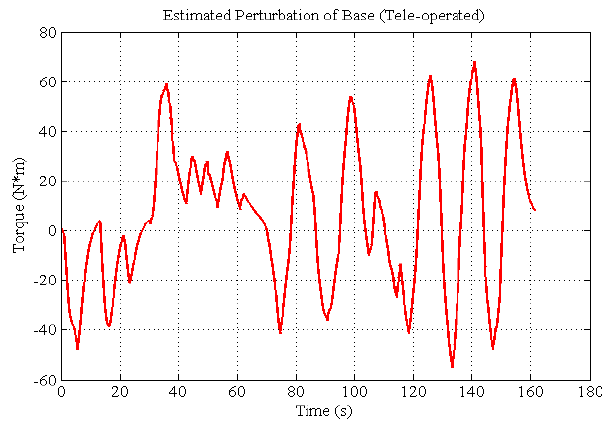
Figure 22. Estimated perturbation of the base for the master.